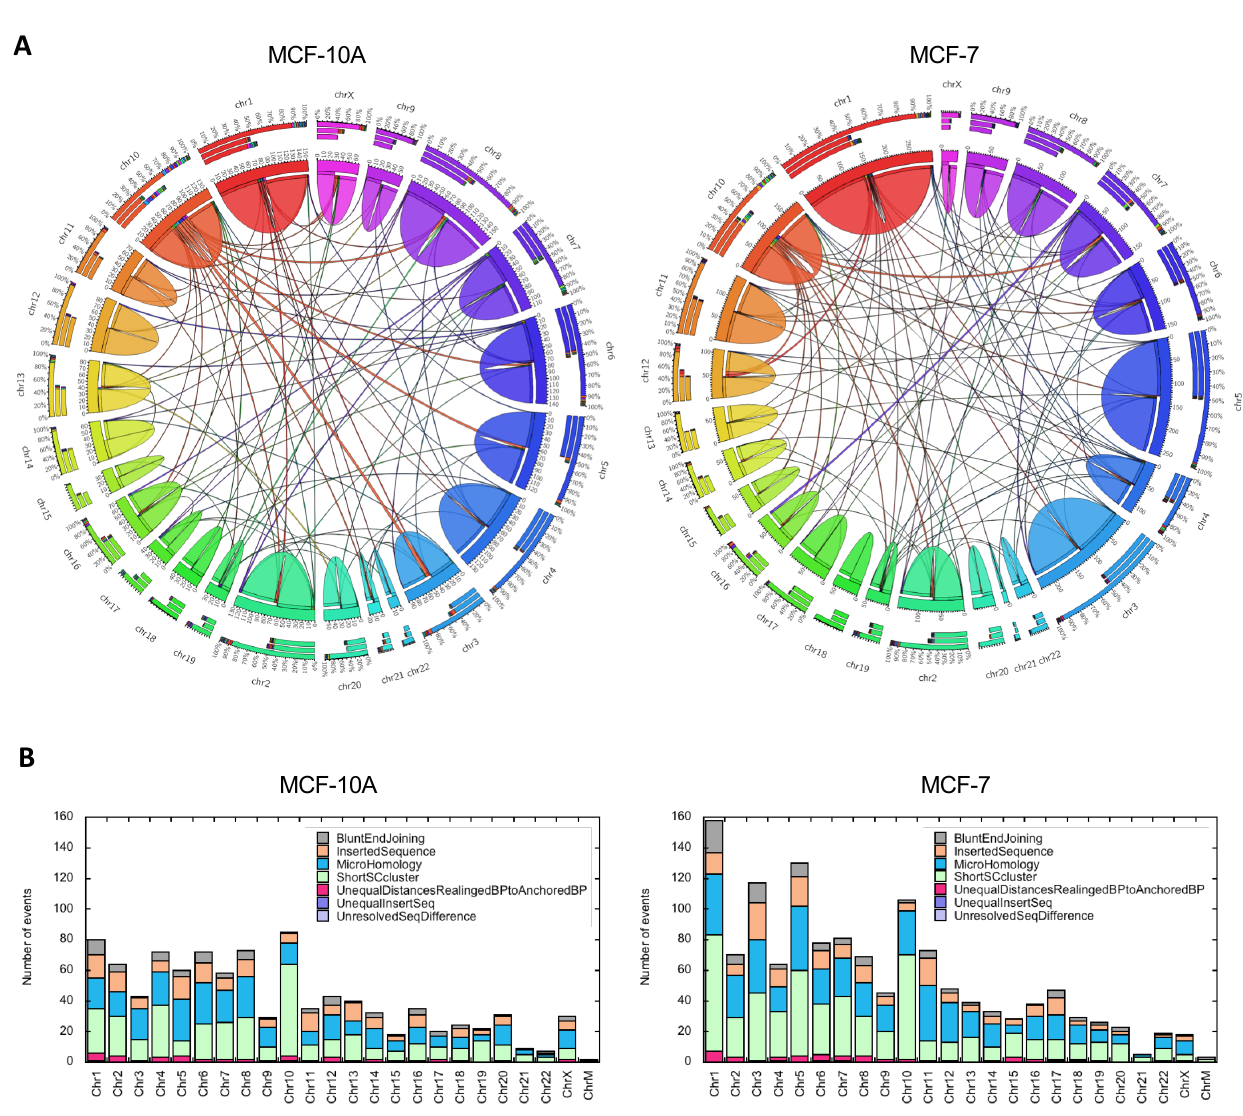
Figure 5. Structural variations in MCF-10A and MCF-7 cell lines. ( A ) Circos displays of paired structural variation events detected by Socrates for MCF-10A (971 events) and MCF-7 (1334 events). Each chromosome is color-coded. Intra-chromosomal breakpoints are represented by the dome above the chromosome; the width of the dome corresponds to the number of events. Inter-chromosomal translocations are represented by ribbons connecting the two translocated chromosomes, with the thickness of the ribbon corresponding to the number of events. The bar graphs beneath the chromo- some indicate the relative proportion of intra- (same color of the chromosome) and inter- (color of the connecting chromosome) chromosomal events. ( B ) Structural variants from paired chromosomal translocations were further classified into seven categories as indicated, and plotted as stacked column plots for each